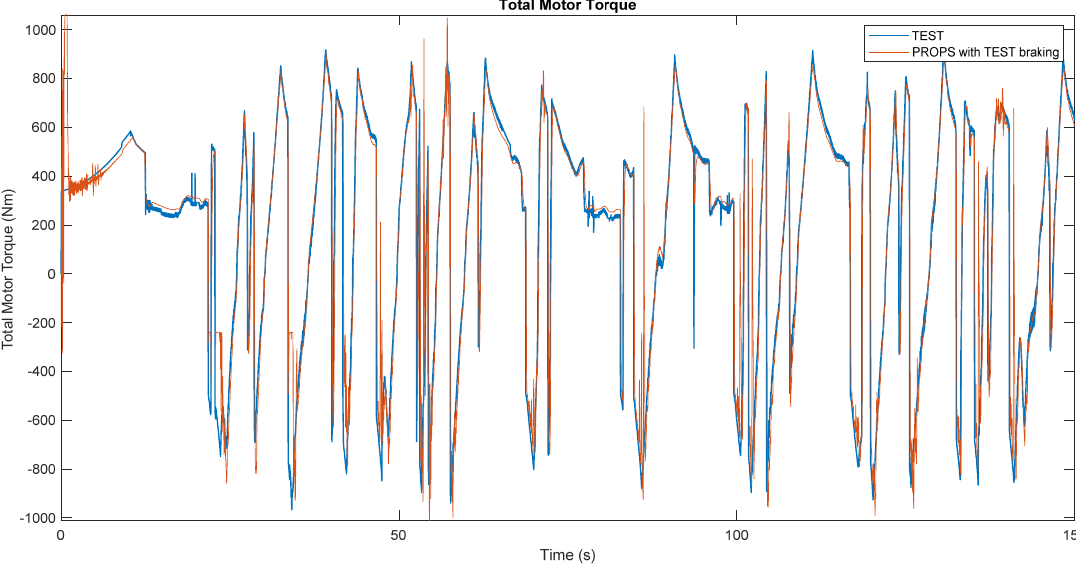
Figure 22. This graph shows TEST (in blue) and PROPS (in red) total motor torque (in Nm) vs. Lap Time (in seconds).